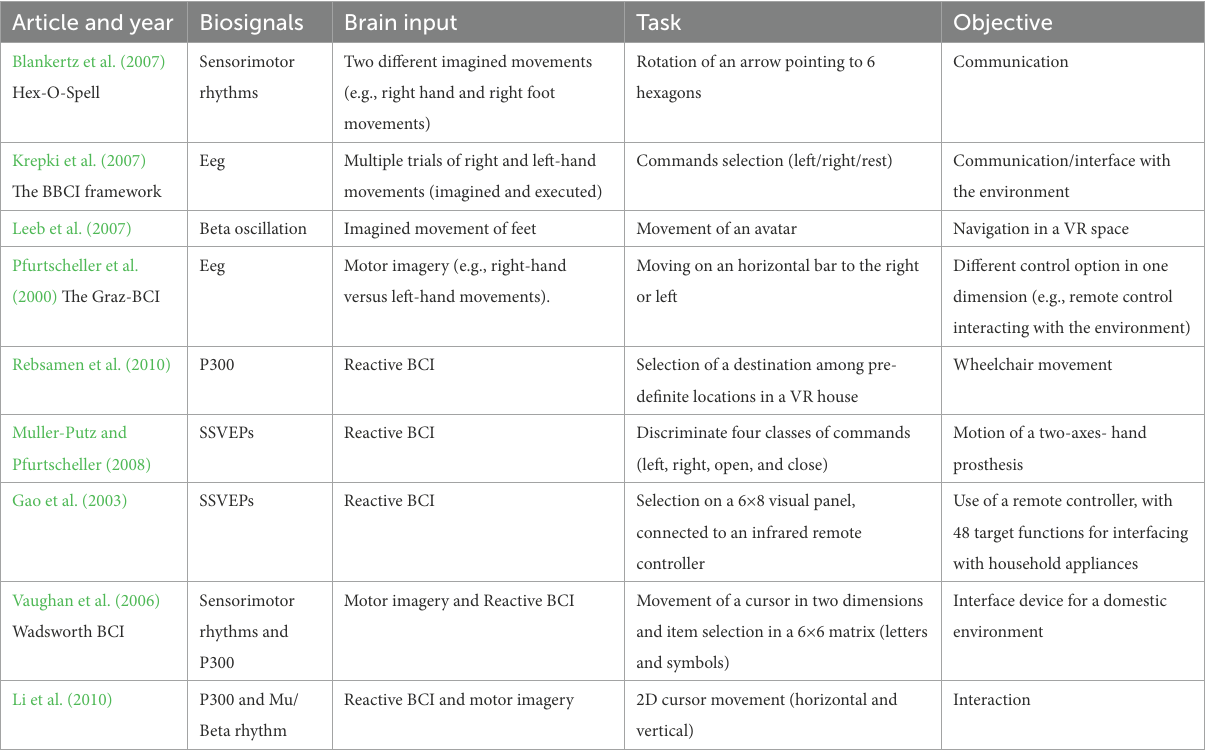
TABLE 4 The milestones research studies in Brain-Computer